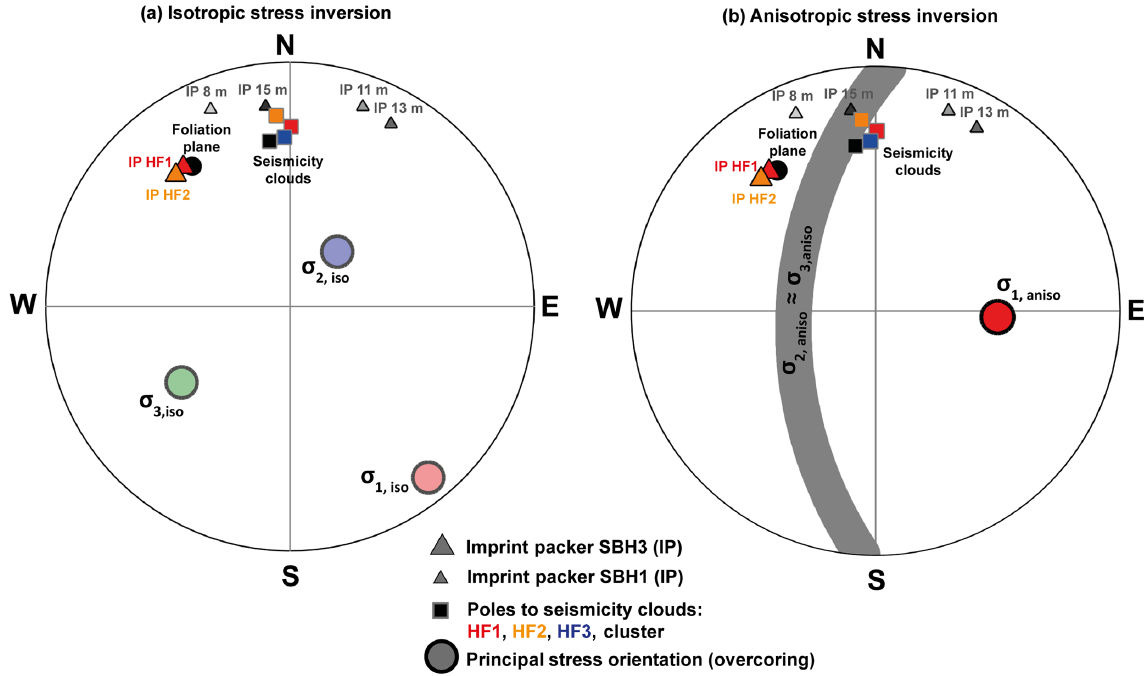
Figure 13. Comparison of seismicity cloud directions with the foliation plane, fractures mapped on imprint packers (IPs) and the principal stress directions from overcoring ( σ 1 − 3 ) with the seismicity clouds; (a) for stress inversion of the overcoring assuming isotropic elastic parameters and (b) for transversely isotropic elastic parameters (Krietsch et al., 2017).